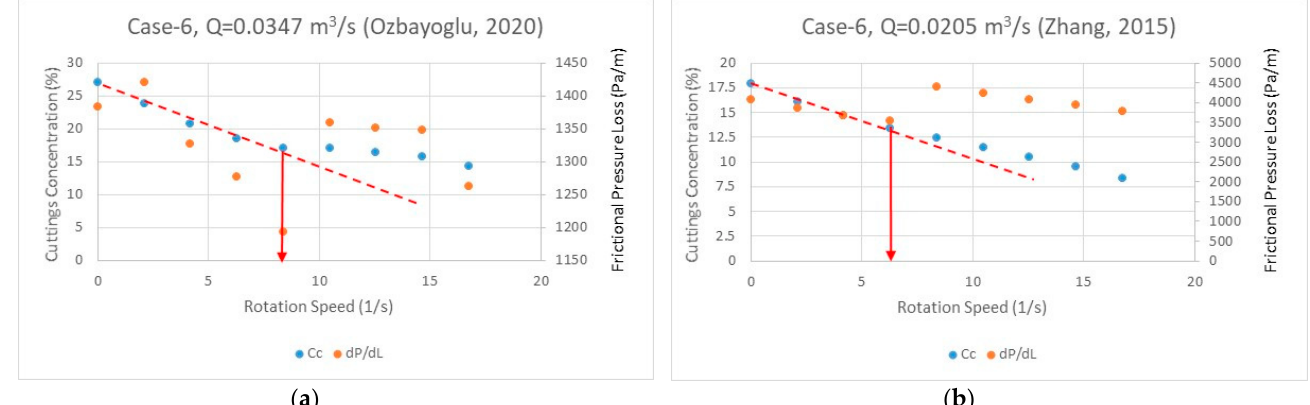
Figure 12. Determination of the optimal pipe rotation speed after the optimal flow rate is determined for Case 6: ( a ) Ozbayoglu’s model and ( b ) Zhang’s model